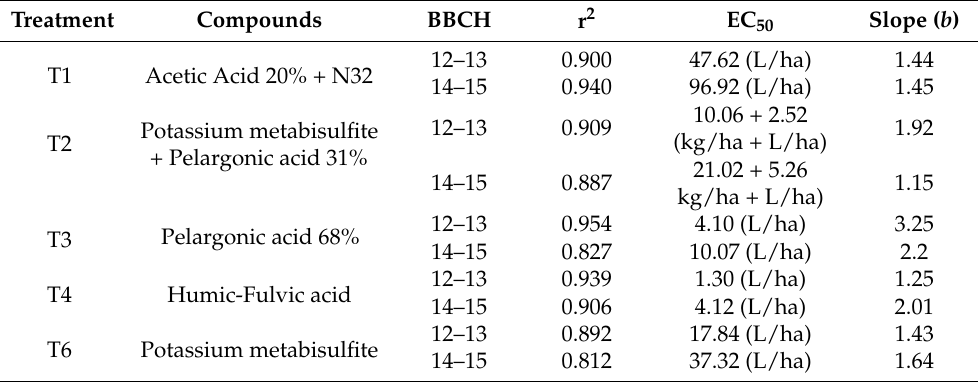
Table 6. Parameters of dose–response curves represented in Figure 2. T1: acetic acid 20% + N32, T2: potassium metabisulfite + pelargonic acid 31%, T3: pelargonic acid 68%; T4: humic-fulvic acid, T6: potassium